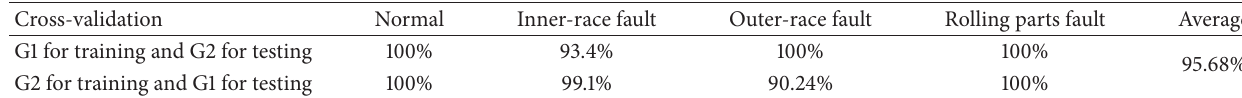
Table 6: Identification results on four fault